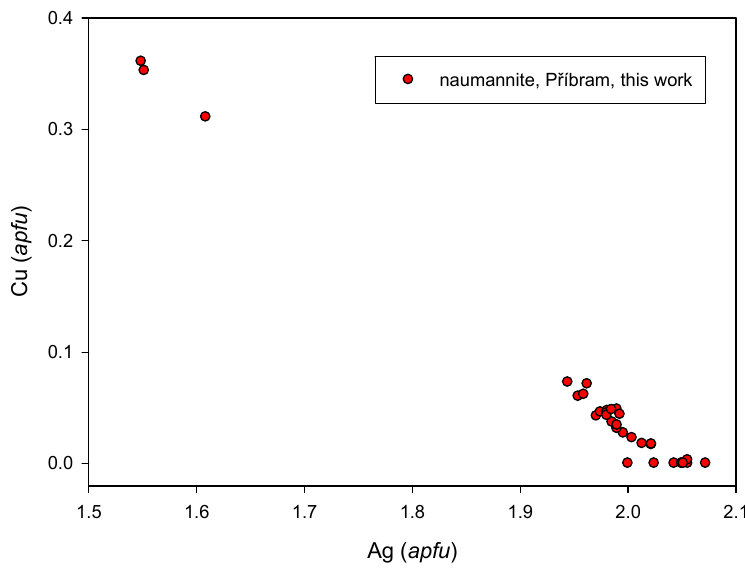
Figure 42. Ag vs. Cu ( apfu ) graph for naumannite.